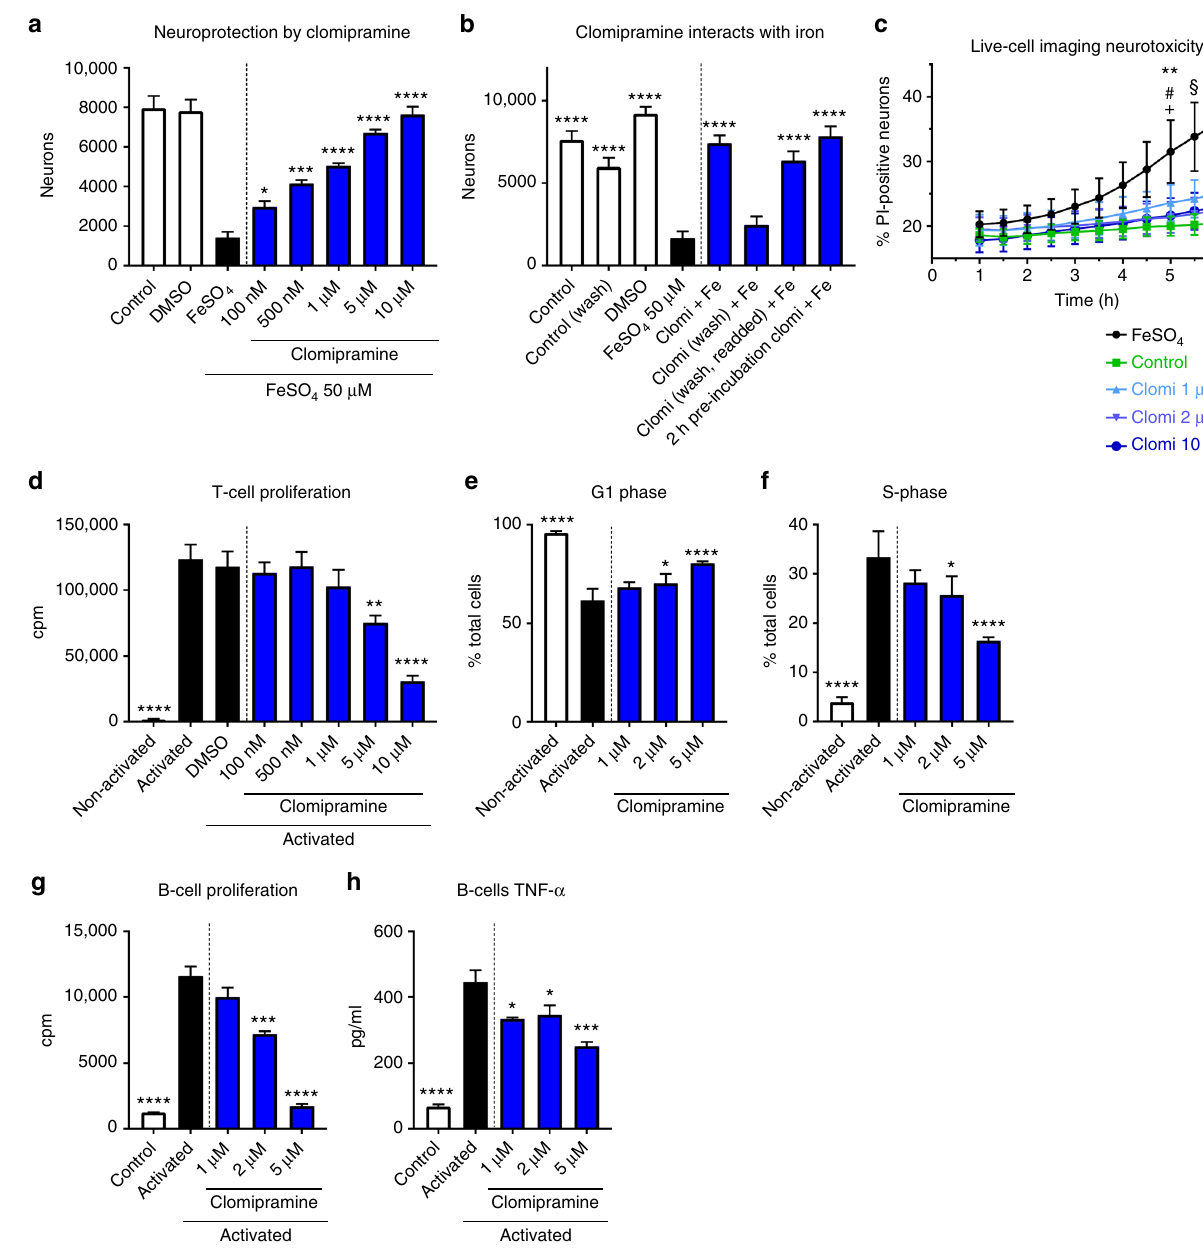
Fig. 6 Clomipramine reduces iron neurotoxicity and proliferation of T-lymphocytes and B-lymphocytes. Clomipramine attenuated iron-mediated neurotoxicity in a concentration-dependent manner from 100 nM ( p < 0.05) ( a ). Washing away clomipramine led to cell death by iron, but this effect could be prevented after pre-incubation of clomipramine with iron, suggesting a physical reaction between clomipramine and iron ( b ). Live-cell imaging studies show that the increasing accumulation of PI-positive neurons exposed to iron over time was prevented by clomipramine ( c ). Clomipramine furthermore reduced the proliferation of T-lymphocytes ( d ), re fl ected by a reduction of cells in S-phase and an increase in the G1-phase of the cell cycle ( e , f ). Proliferation of activated B-cells was reduced by clomipramine from 2 µ M ( g ), correspondent with reduced TNF- α release ( h ). Data are shown as quadruplicate replicate wells of an individual experiment that was conducted twice ( a , d , e , f ), once ( b ) or three times ( g , h ); c represents triplicate wells of one experiment. Results are mean ± SEM. One-way ANOVA with Dunnett's multiple comparisons test as post hoc analysis compared to the FeSO 4 or activated condition ( a , b , d – h ) and two-way ANOVA with Dunnett's multiple comparisons test ( c ): * p < 0.05; ** p < 0.01; *** p < 0.001; **** p < Another model of chronic EAE, thought to model secondary progressive multiple sclerosis 22,23 , is immunization with spinal cord homogenate (SCH) in the Biozzi ABH mouse. Clomipra- mine treatment was started at the onset of clinical signs where it reduced clinical severity throughout the period of treatment ( p = 0.0062) (Fig. 10c). and chronic EAE in two different mouse models. Figure 10d